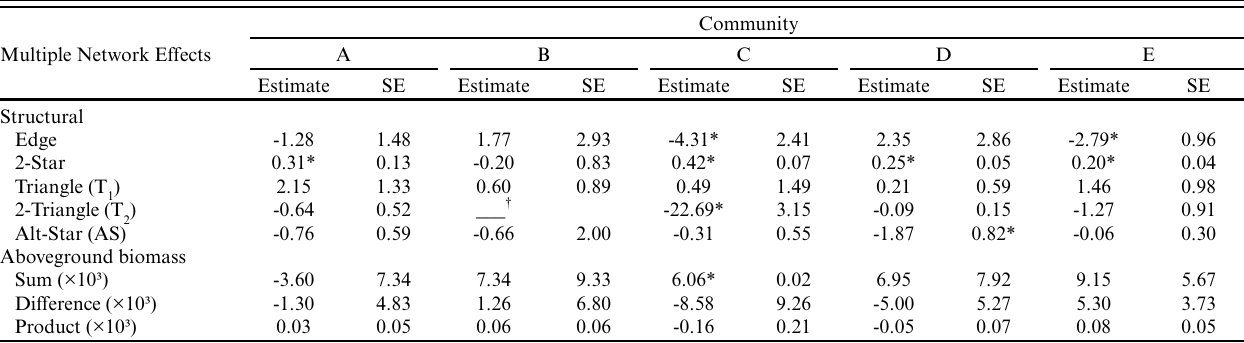
Table 5 . Results from the exponential random graph model (ERGM) parameter estimation. Goodness of fit: The t statistics of all parameters included in the model were below the threshold value of 2, thus suggesting a good model fit (Koskinen and Snijders 2012, Robins and Lusher 2012). * P < 0.05. SE, standard error.